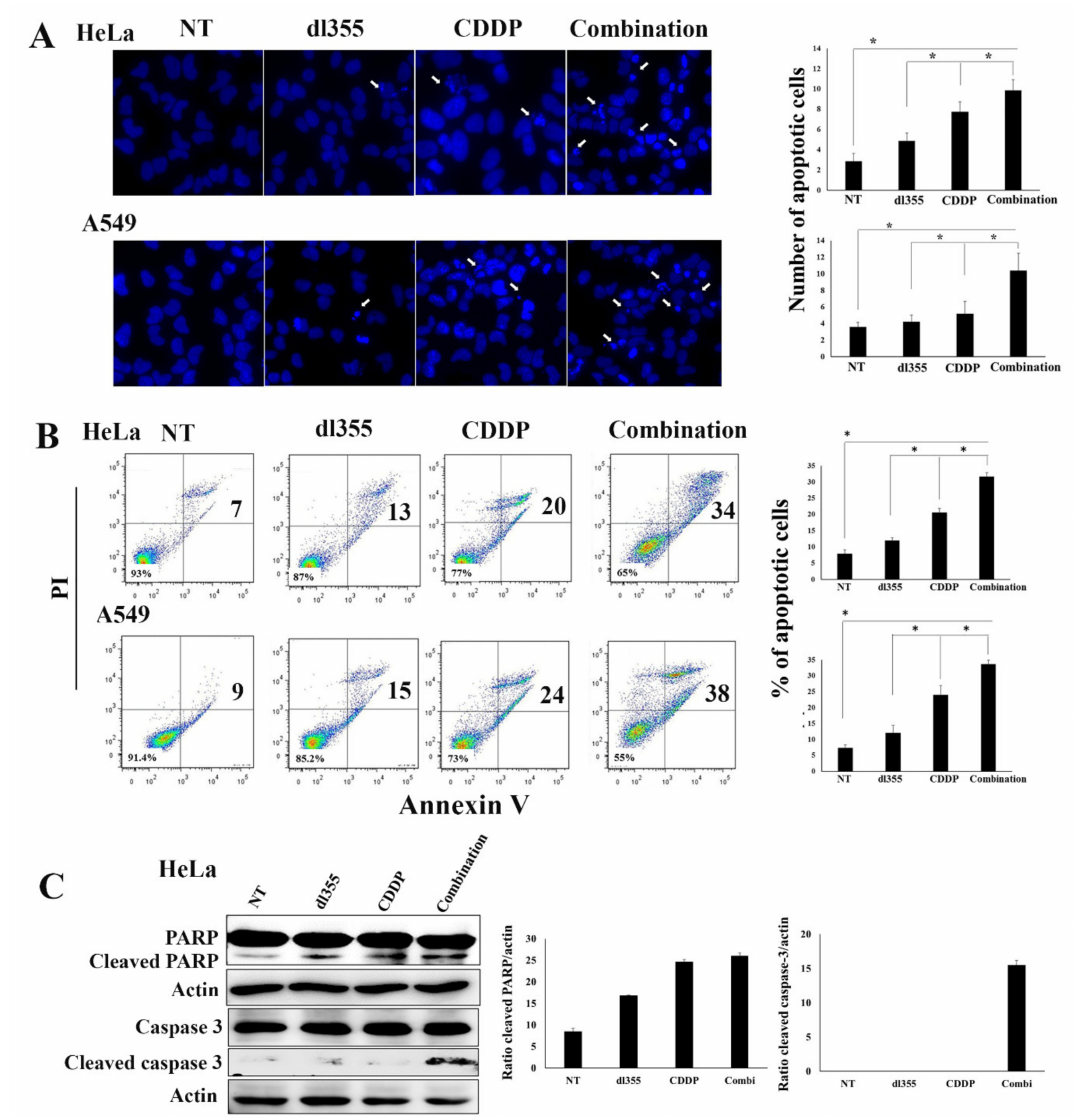
Figure 4. Evaluation of apoptosis induction of tumor cells by combination therapy. HeLa and A549 cells were treated with dl355 (MOI 10 vp / cell) or CDDP (1.25ug / mL) or combination (CDDP 1.25 µ g / mL plus dl355 MOI 10; vp / cell) therapy for 72 h. For combination therapy, cells were treated with CDDP for 4 h before infection with the virus. The induction of the caspase pathway is observed only in the HeLa cell line. ( A ). Hoechst 33342 staining (1 mg / mL) for 30 minutes was used to detect apoptosis. Arrow marks indicate the condensed and fragmented nuclei. The number of apoptotic cells is quantitated in the histogram (right panel). ( B ). After incubation with annexin V and propidium iodide (PI), apoptotic cell detection was done by flow cytometry. The percentage values are shown at the right of each plot belong to the two quadrants on the right. The number of apoptotic cells is quantitated in the histogram (right panel). ( C ). HeLa cell was treated with similar treatment, as mentioned above. Activation of the caspase pathway was detected by western blot analysis. The bar chart shows the quantification of the cleaved PARP and cleaved caspase-3 level compared to actin in each condition (right panel). The result shown is from a single experiment representative of two similar experiments. * indicates p <